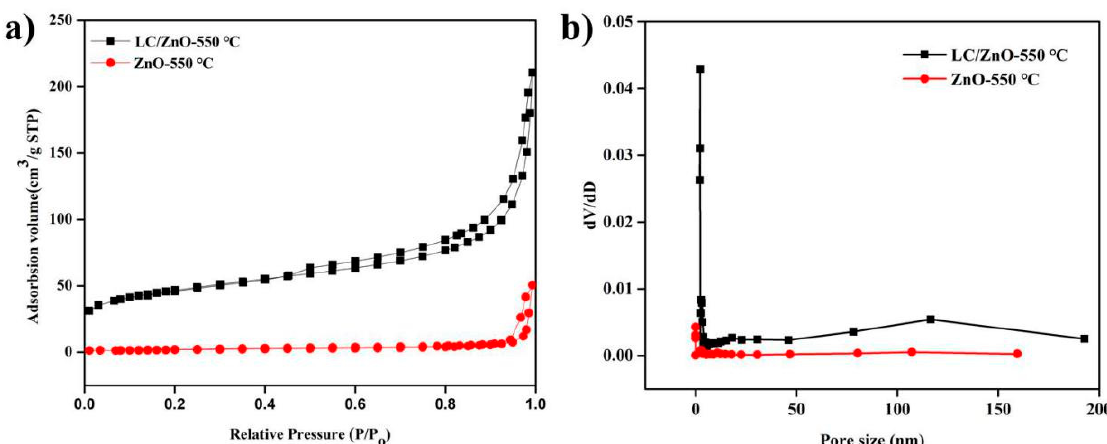
Figure 5. Nitrogen adsorption and desorption isotherms and pore size distribution of LC/ZnO-550 °C and ZnO-550 °C: ( a ) nitrogen adsorption and desorption isotherms; ( b ) pore size distribution.